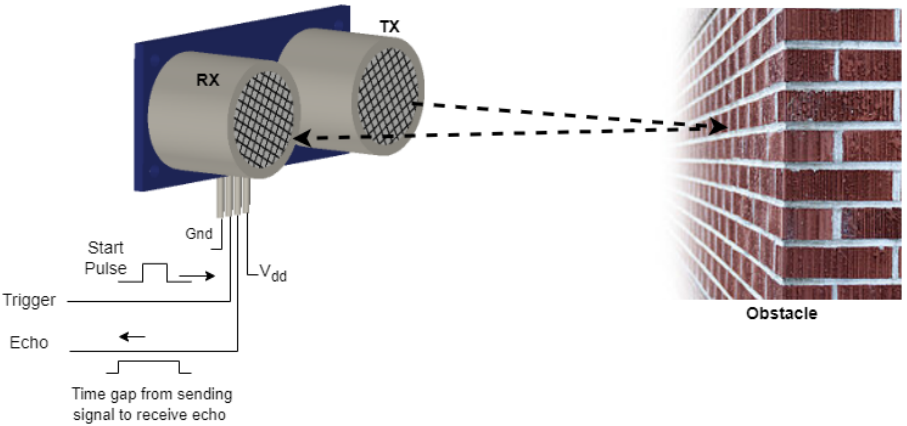
Figure 1. Working of the ultrasonic